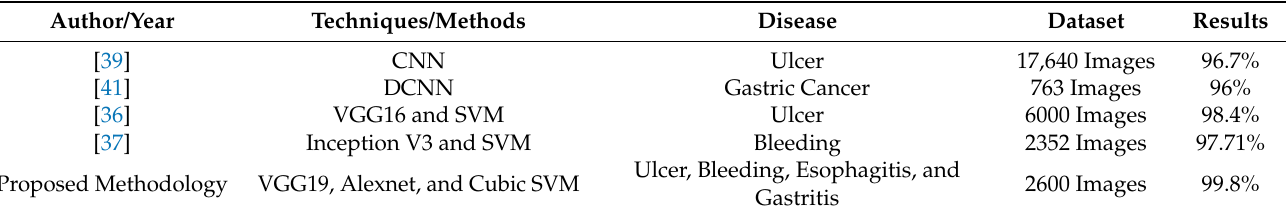
Table 8. Comparison of the proposed methodology with the state-of-the-art